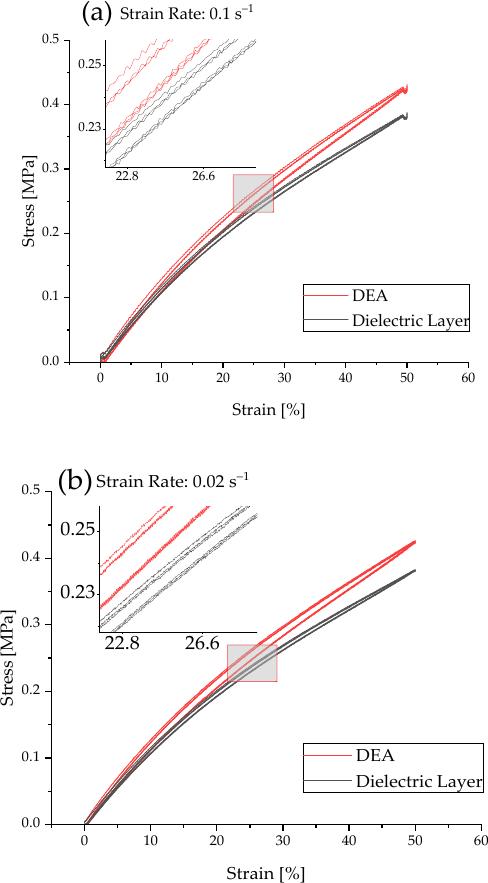
Figure 5. Stress–strain hysteresis at a strain rate of ( a ) 0.1 s − 1 and ( b ) 0.02 s − 1 of a DEA and of the pure dielectric